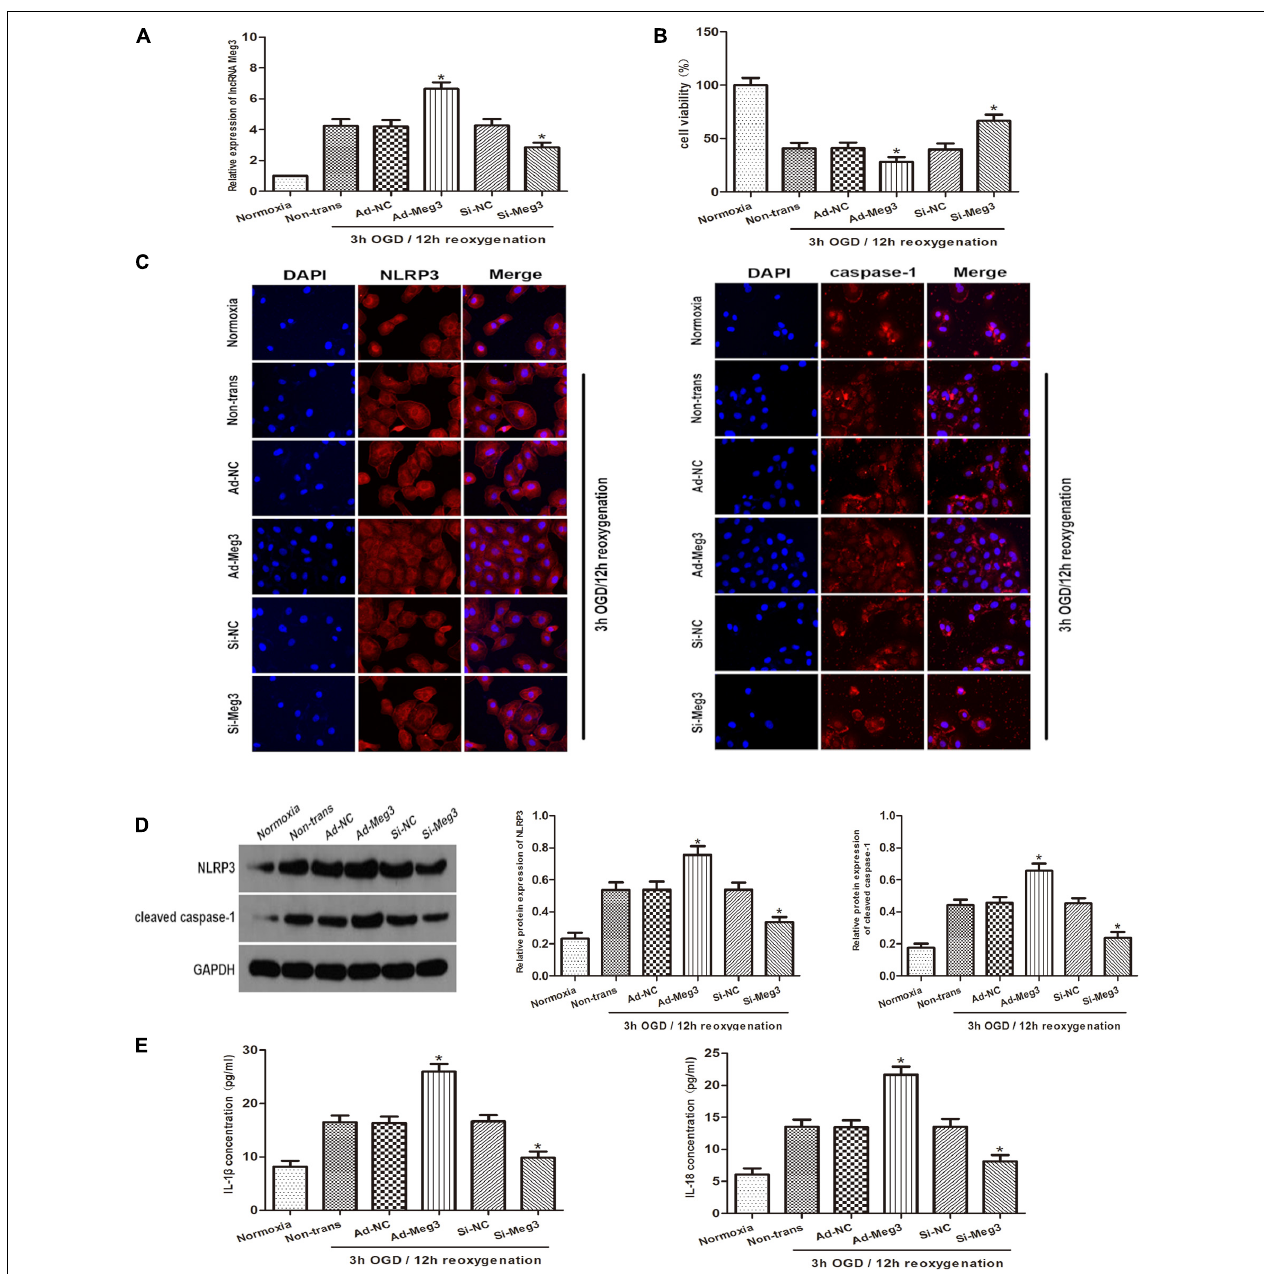
FIGURE 2 | Influence of lncRNA MEG3 on pyroptosis and inflammation of GC-1 cells in vitro . (A) Comparison of relative expression levels of MEG3 in cells transfected with ad-MEG3 or si-MEG3. (B) Cell viability were compared by CCK-8 between NC group cells and cells transfected with ad-MEG3 or si-MEG3 under normoxia or 3 h/12 h OGD/R treatment. (C) Expression levels of NLRP3 and caspase-1 were compared by immunofluorescence between NC group cells and cells transfected with ad-MEG3 or si-MEG3 under normoxia or 3 h/12 h OGD/R treatment. (D) Cleaved caspase-1 and NLRP3 protein levels were compared by Western blot between NC group cells and cells transfected with ad-MEG3 or si-MEG3 analysis under normoxia or 3 h/12 h OGD/R treatment. (E) IL-1 β and IL-18 expression were compared by ELISA analysis between NC group cells and cells transfected with ad-MEG3 or si-MEG3 under normoxia or 3 h/12 h OGD/R treatment. The data are presented as the mean ± S.E.M. n = 6. * p < 0.05 vs.